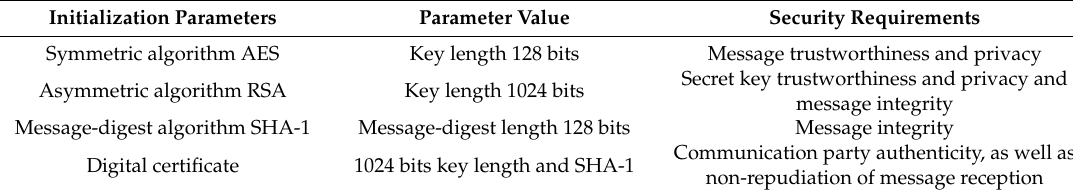
Table 1. Parameters for the model